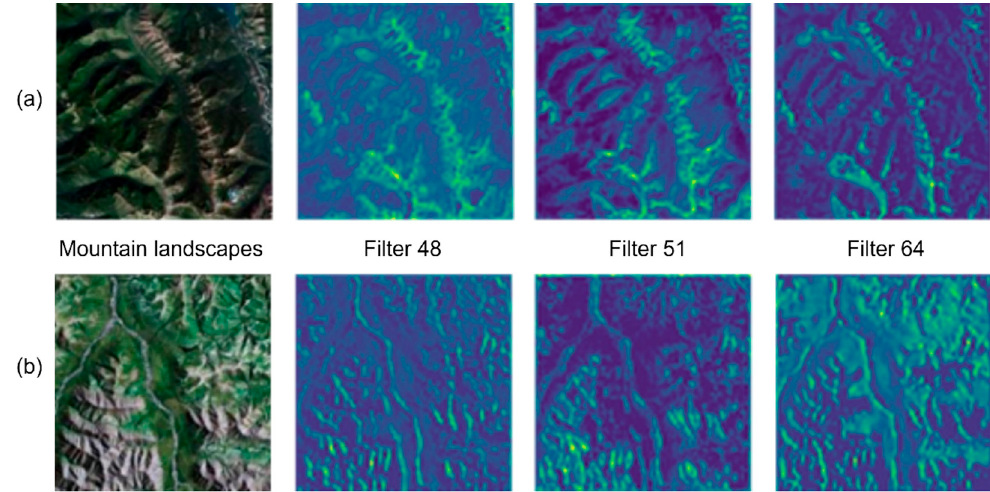
Figure 8. Mountain sample landscapes. Row ( a ) shows a sample mountain from Sentinel dataset. Row ( b ) shows a sample mountain from AID dataset. Feature maps are from Filters 48, 51, and 64.